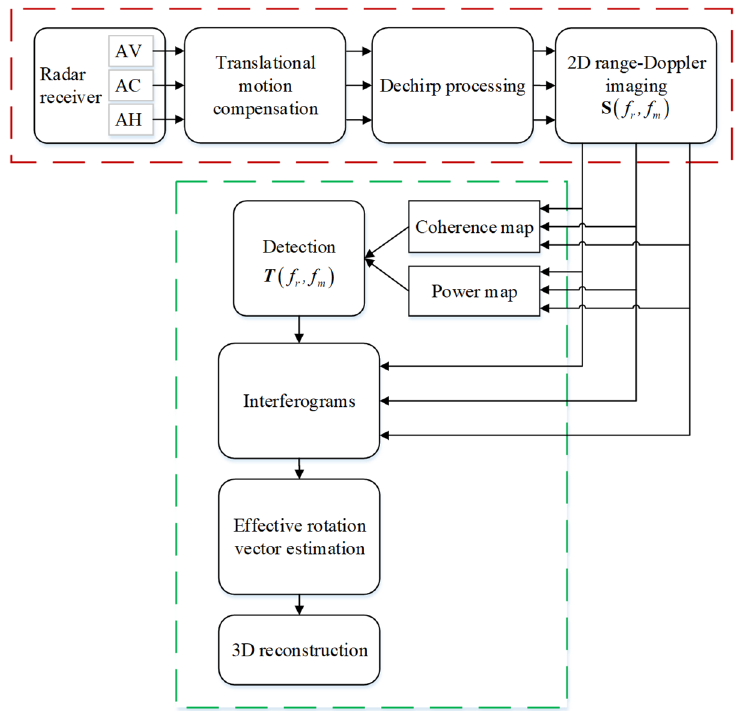
Figure 1. Overall flowchart of 3D target reconstruction with the proposed algorithm.